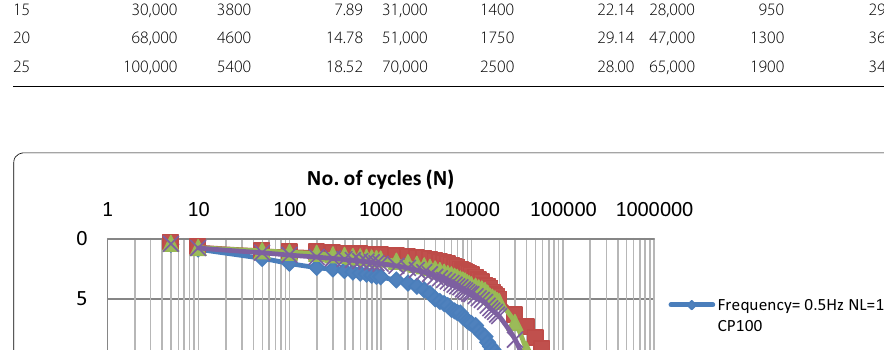
1 and CP = 1; CP 100 kPa = =